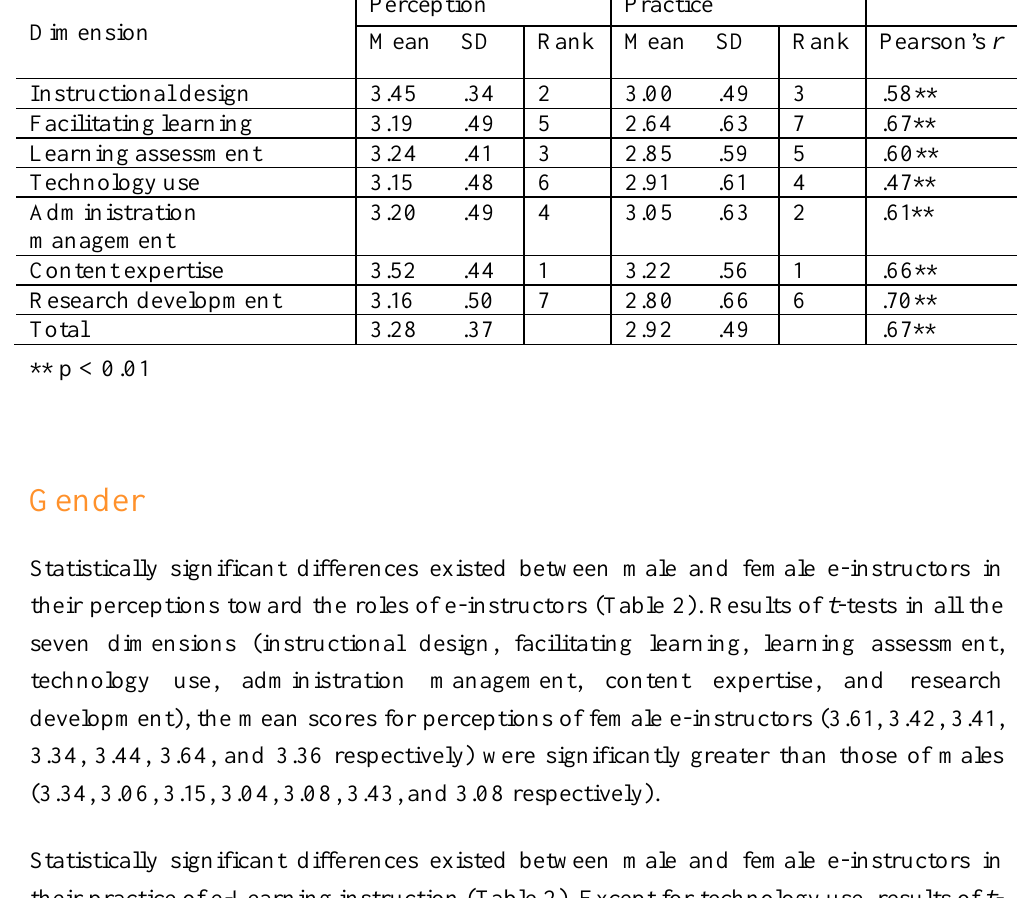
Table 1 Pearson’s r between Perception and Practice of E-Instructors toward Online Instruction